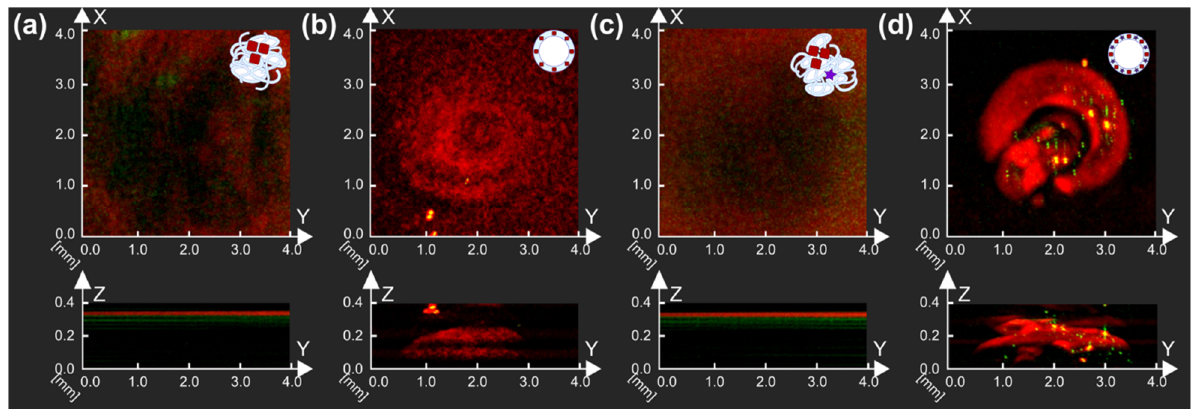
Figure 6. Raster-scanning optoacoustic mesoscopy measurements of ( a ) Au-BSA solution, ( b ) BSA-Au MBs, ( c ) ZnPc-BSA and Au-BSA solution, and ( d ) BSA-Au-ZnPc MBs. Projections of measurements in X and Y, X, and Z axes are presented.